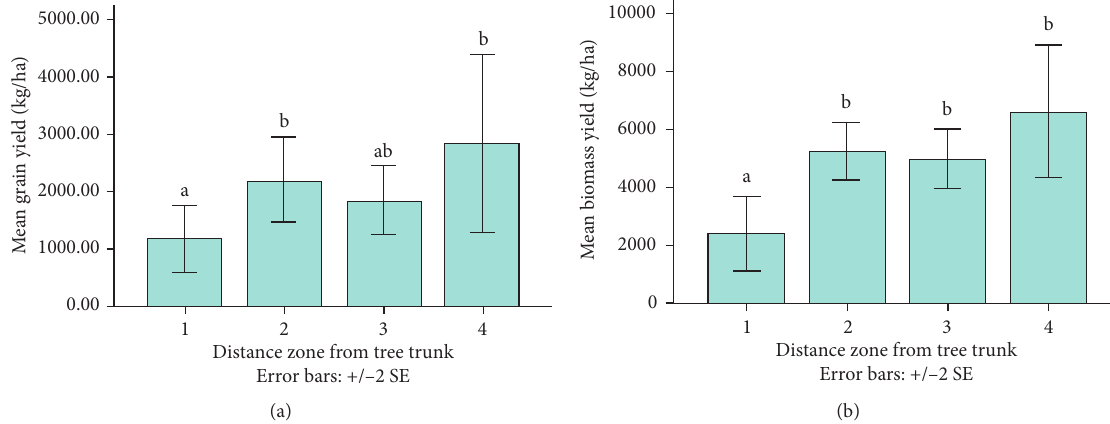
Figure 4: Effect of Acacia seyal on sorghum grain and biomass yield (kg/ha). Graphs with the same superscript letters are not statistically different at P > 0 . 05.